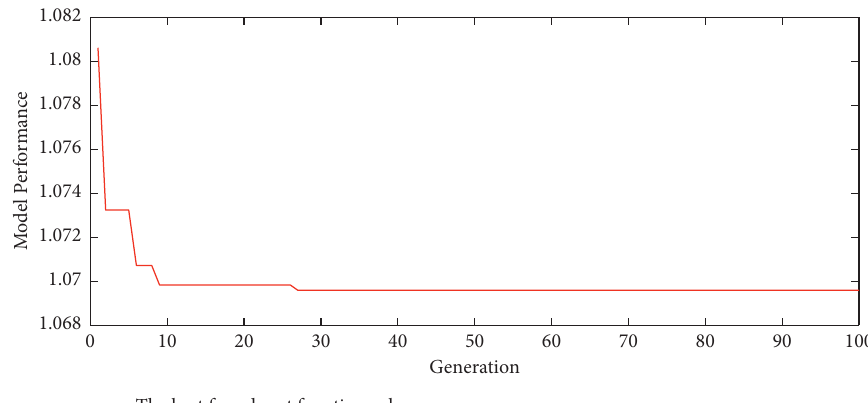
Figure 8: The JS-based model optimization progress.